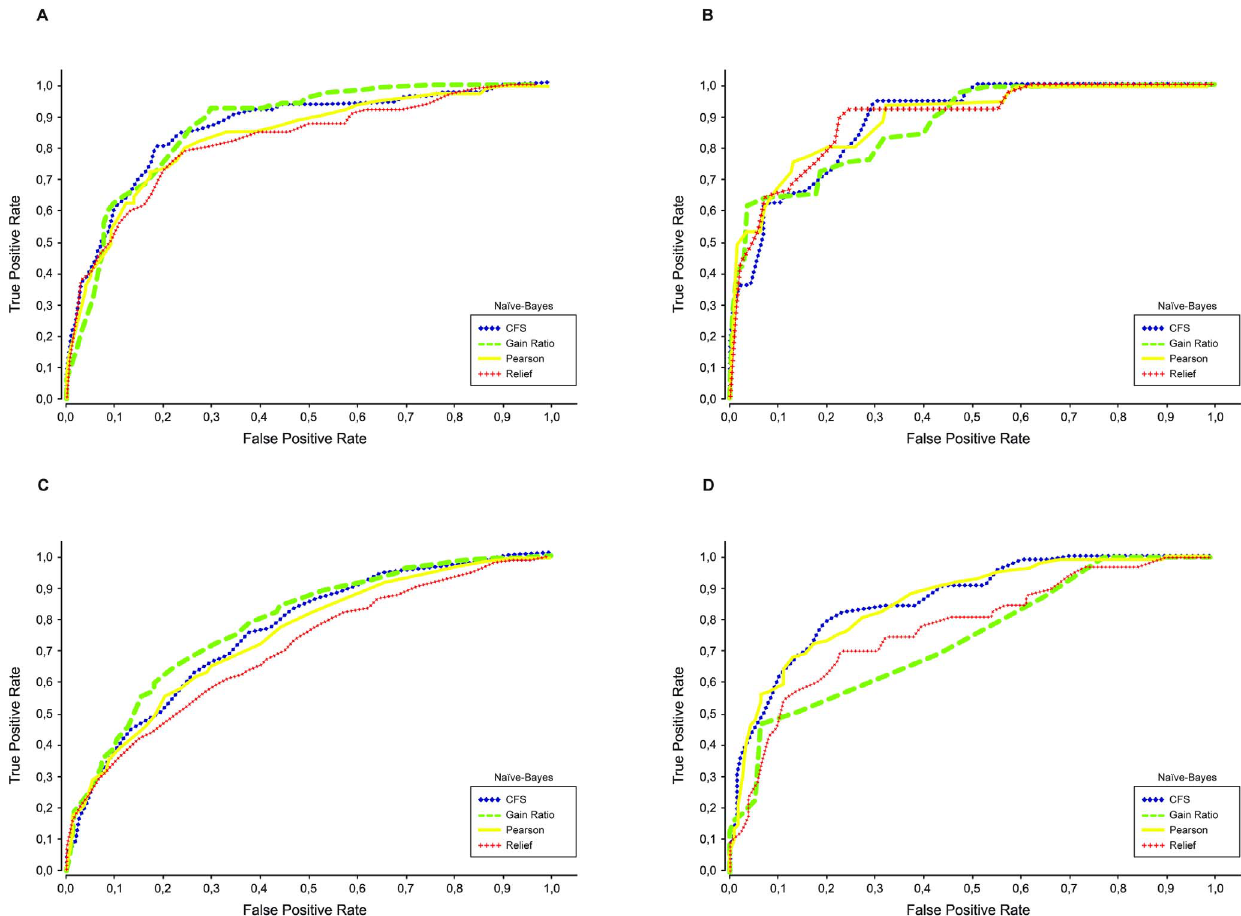
Figure 2. Classifier ROC curves for the Portuguese datasets. The ROC curves illustrate the performance for classifying tweets as related to (positive) or not related to (negative) a given health state. Results shown are for a Naı¨ve Bayes classifier trained with the subsets of features generated by four different feature selection algorithms. A) Depression, B) Pregnancy, C) Flu and D) Eating Disorders.